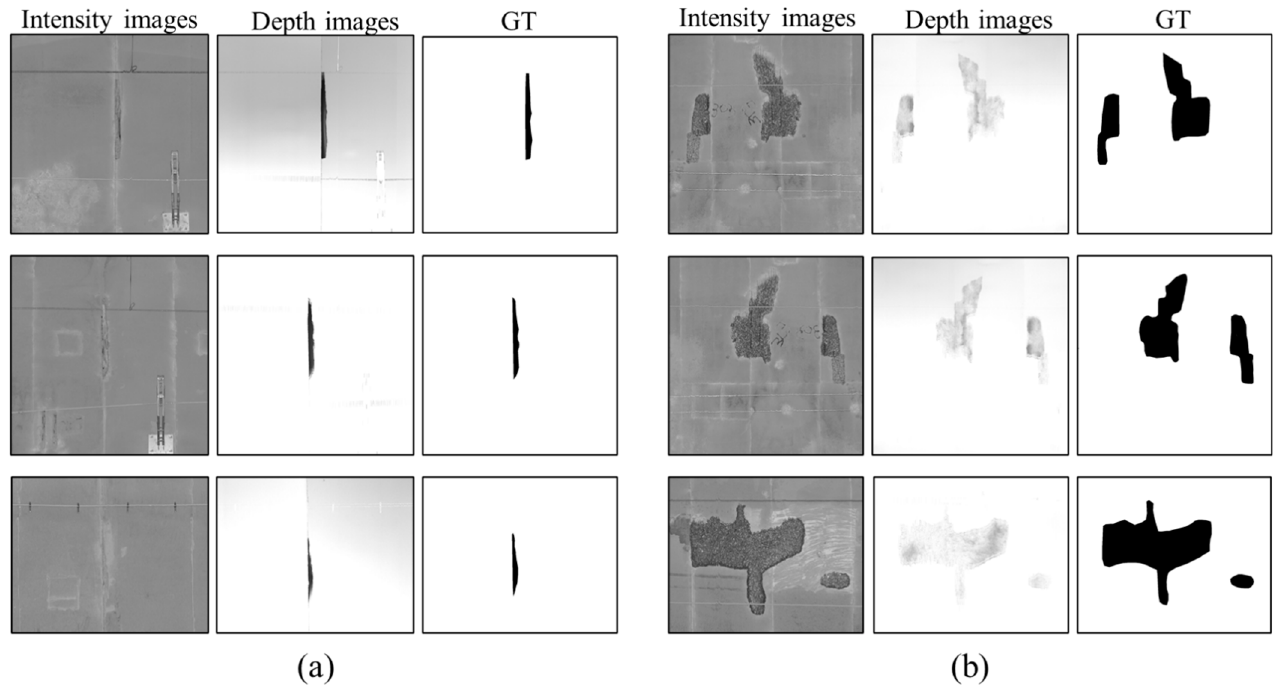
Figure 6. Some examples of the RTSD dataset, including: ( a ) spalling defects images with a large depth and ( b ) spalling defects images with a shallow depth.